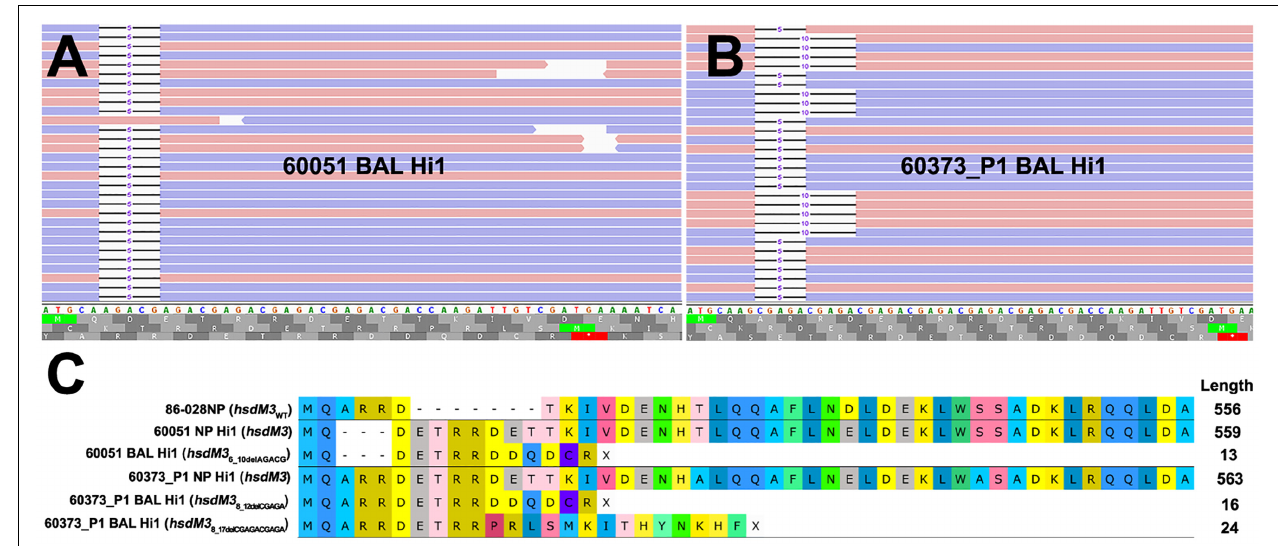
FIGURE 1 | Read mapping analysis of the highly mutable hsdM3 pentanucleotide simple sequence repeat (SSR) tract in 60051 and 60373_P1 NP-BAL pairs. (A) Graphical representation of 60051 BAL Hi1 Illumina reads aligned against the hdsM3 region of the 60051 NP Hi1 reference assembly. One allele consisting of a 5 bp deletion (AGACG) was observed. (B) Graphical representation of 60373_P1 BAL Hi1 Illumina reads aligned against the 60373_P1 NP Hi1 reference assembly. Two different alleles consisting of 5 bp (AGACG) and 10 bp (AGACGx2) deletions were observed in the BAL isolate. Blue and red bars represent forward and reverse reads (respectively). (C) Amino acid alignment of HsdM3 against reference strain 86-028NP (wild-type). NP isolates from 60051 and 60373_P1 encode the full-length protein, with minor differences resulting from the variable SSR tract. Indels in the same SSR tract of both BAL isolates, including the two alleles observed in 60373_P1, result in a loss-of-function frameshift that is predicted to yield a truncated protein of